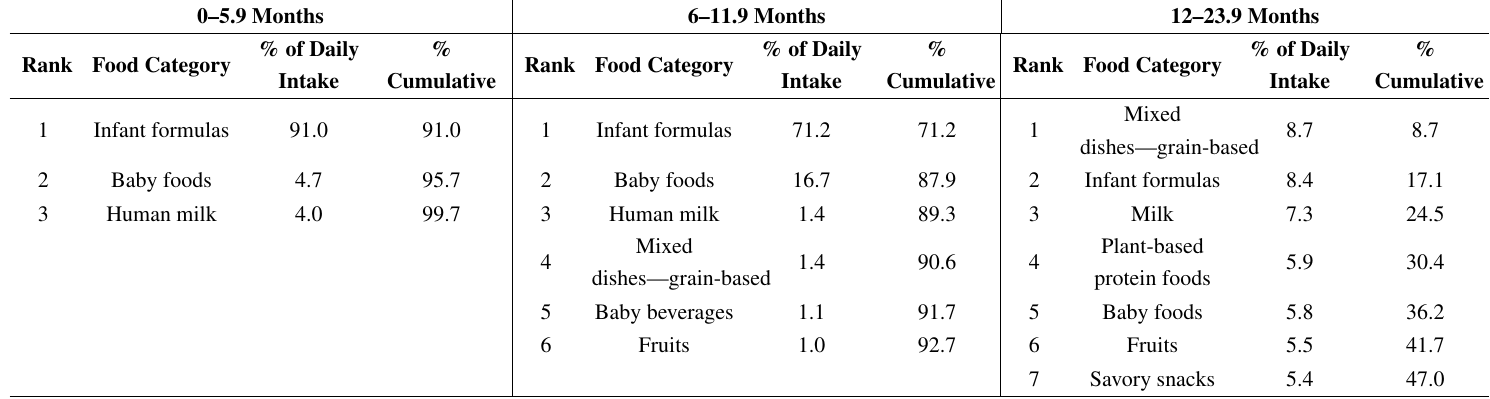
Table 13. Food sources of Vitamin E among US infants and toddlers aged 0–23.9 months by age group: NHANES 2005–2012 ( n = 2740) a